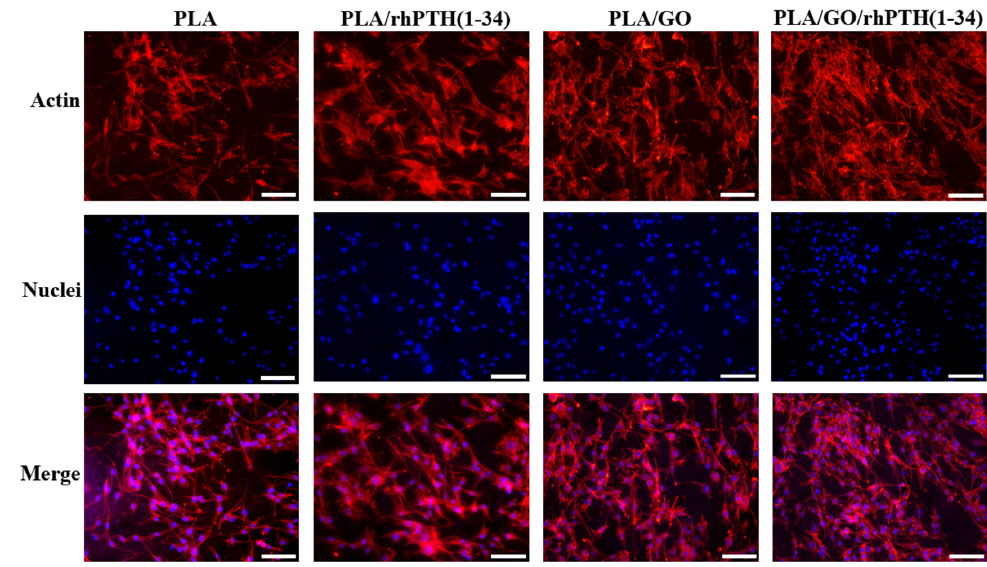
Figure 7. Cell adhesion and extension assay (100× magnification, Bar = 100 µm).